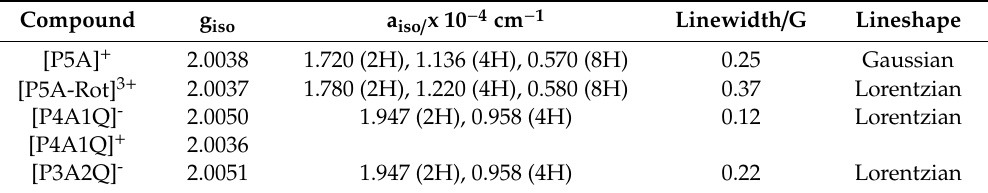
Table 3. EPR spectroscopic data a